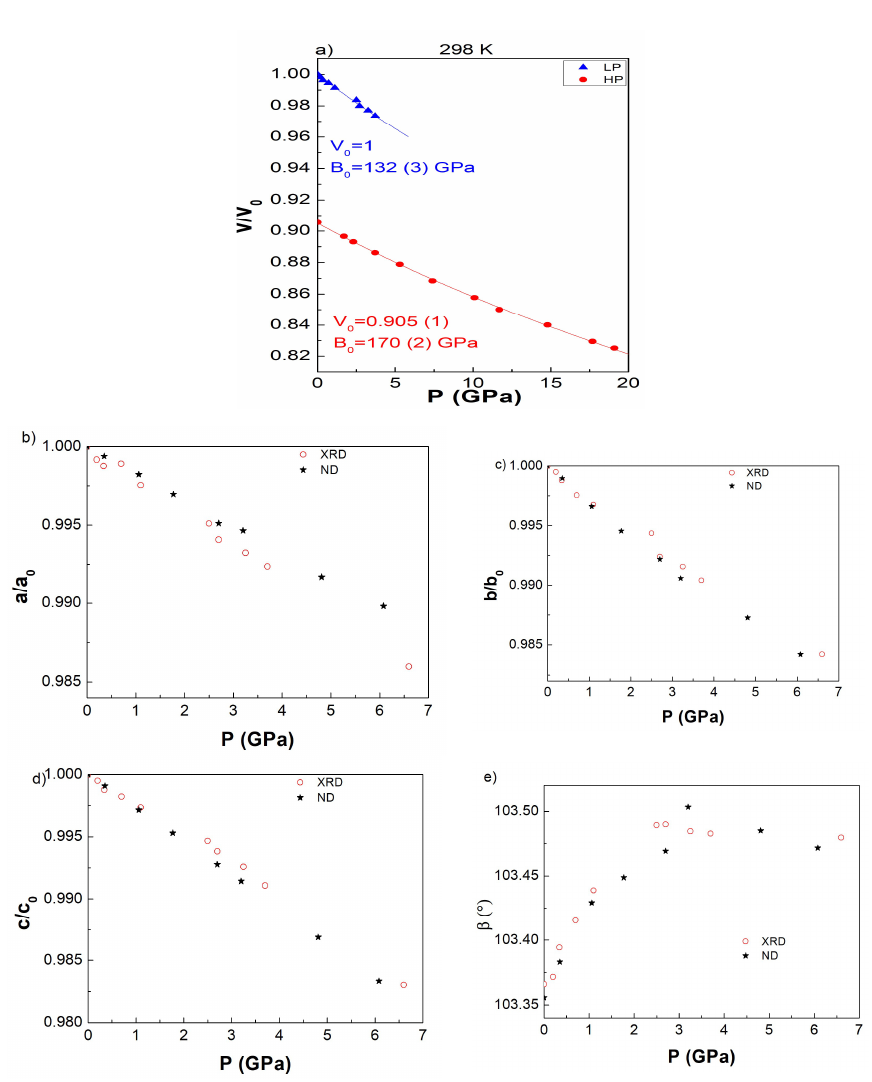
Figure 5. Pressure dependence at 298 K of ( a ) the LuFe 2 O 4 low pressure monoclinic M1 and M2 high pressure forms, the relative monoclinic cell parameters ( b ) a / a 0 ; ( c ) b / b 0 ; (d) c / c 0 and ( e ) the monoclinic β angle.